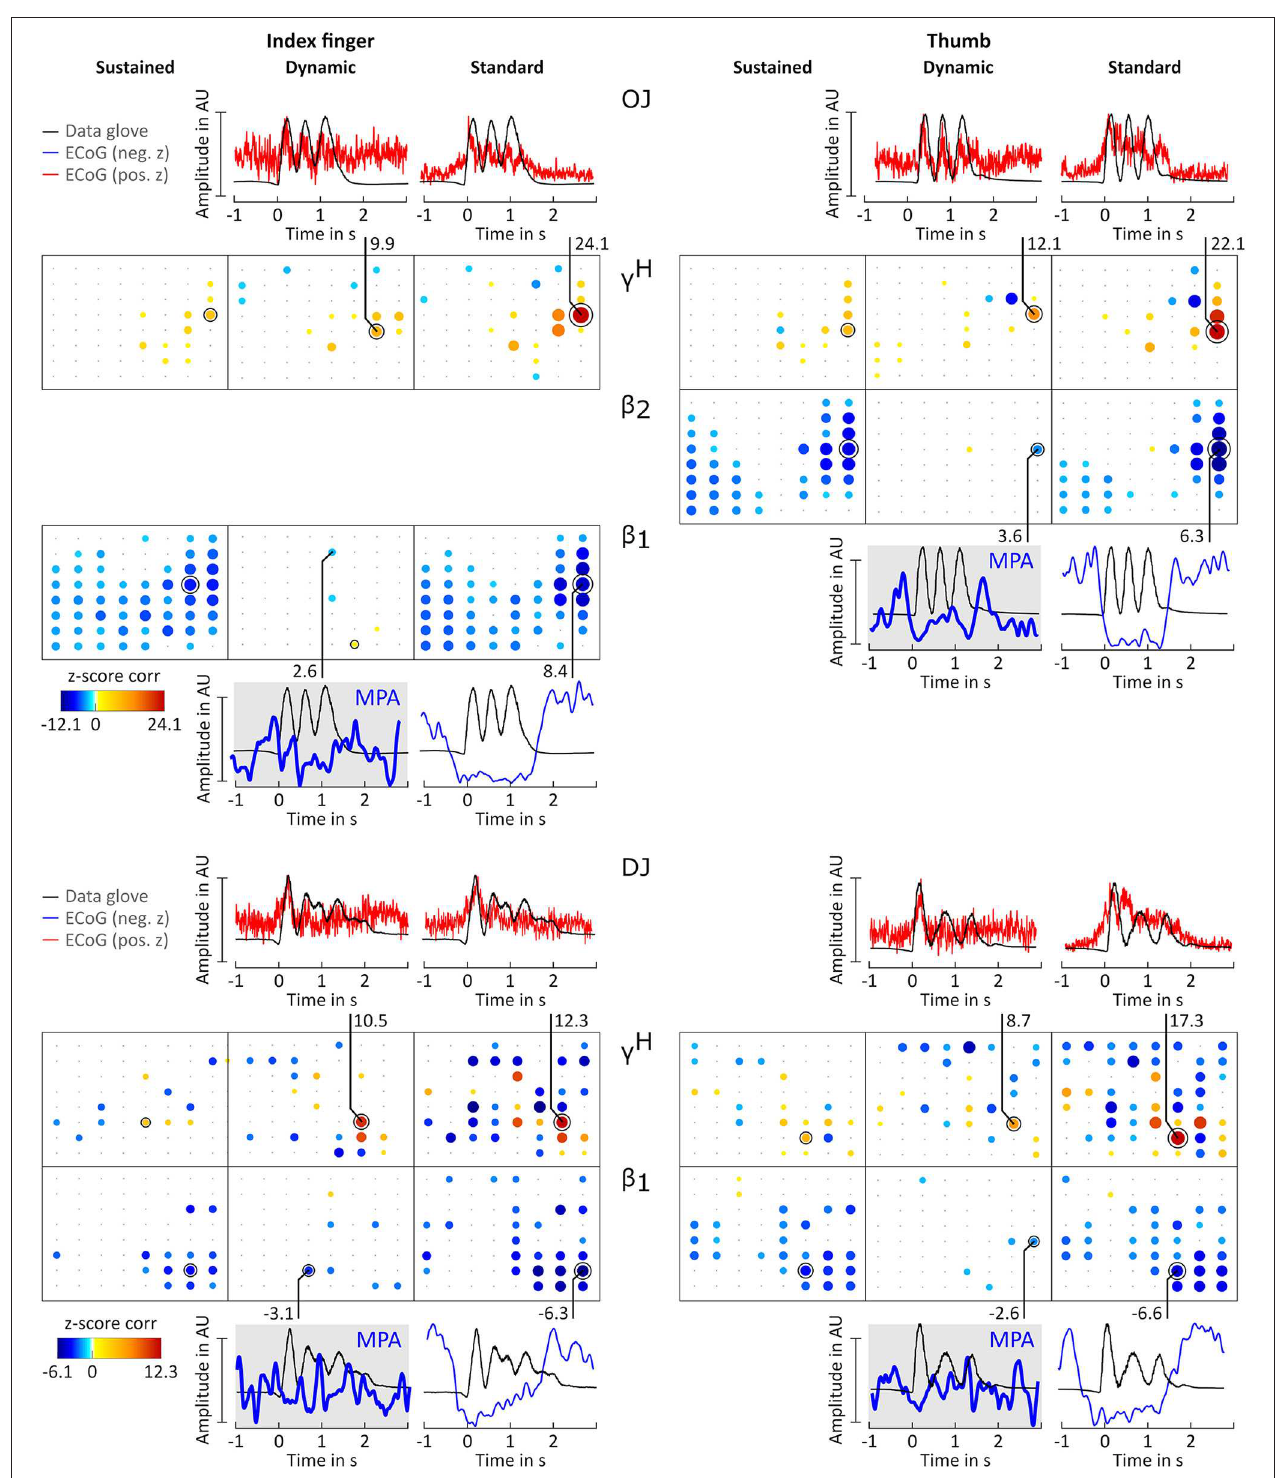
FIGURE 5 | Correlation analysis results and MPA for subjects OJ and DJ. Significant z-score transformed Pearson correlation coefficients for each channel, topographically arranged in bubble plots, for index finger (left) and thumb (right) are displayed. For each subject all conditions (columns, sustained, dynamic, and standard) of γ H = 70 − 150 Hz and the sub-band β 1 = 12 − 18 Hz or β 2 = 18 − 24 Hz with the highest significant z-scores are displayed. Bubble size and color is not directly comparable from subject to subject due to different color-bar ranges. For more detailed description see Figure 3 .